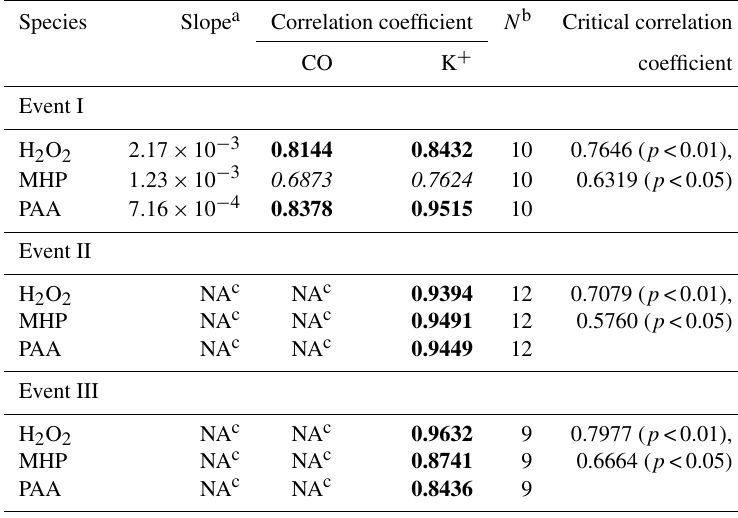
Table 3. Linear regression of atmospheric peroxide species to CO and K + for three biomass burning events during the Phase II (15–17 June). Correlation coefficients shown in italic and bold indicate statistical significance ( p <0.05) and higher statistical significance ( p <0.01), respectively. Species Slope